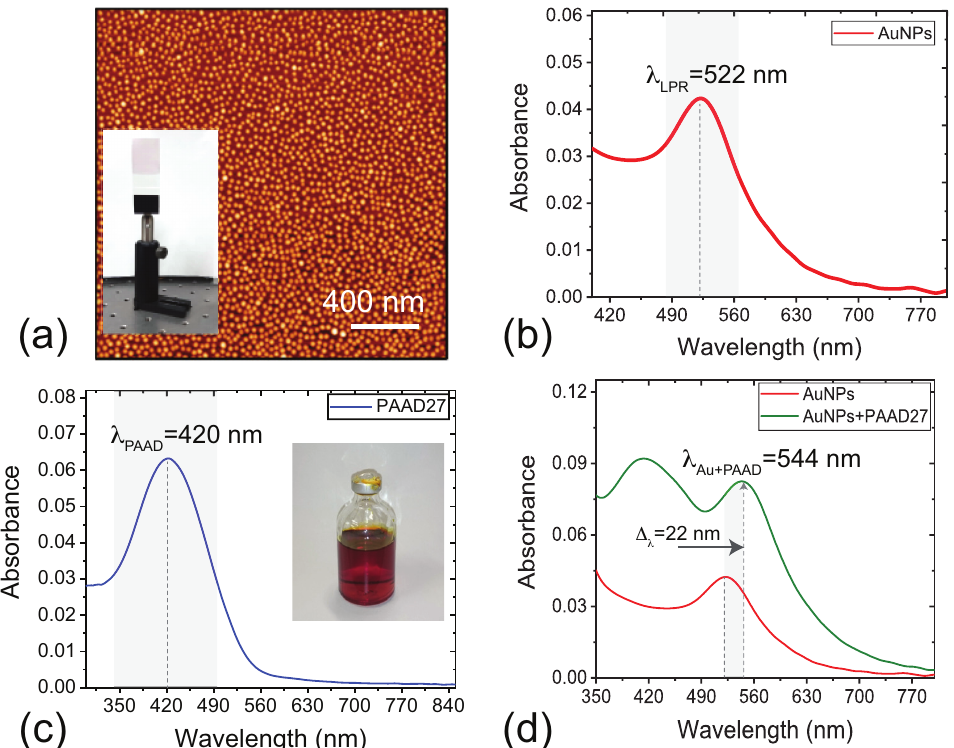
Figure 1. ( a ) AFM image of the AuNPs monolayer on a glass substrate. In the inset, a photograph of the sample. Spectral response of the AuNPs monolayer surrounded by ( b ) air and ( c ) PAAD-27; In the inset, a photograph of the photo-aligning material. ( d ) Absorbance response of the AuNPs monolayer covered by the